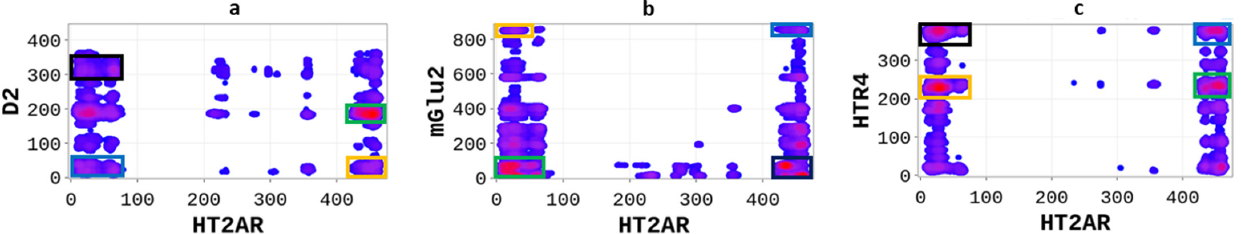
Figure 4. Differential heterodimerization of 5-HT2AR/D2R ( a ), 5-HT2AR/mGluR2 ( b ), and 5- HT2AR/5-HTR4R ( c ). The SP-DCA maps were obtained as described in the text using a total number of interacting aa, 𝑙 = 21 with optimized parameters 𝑎 = 𝑏 = 0.001. Amino acids are gradient color-coded: no interaction (white areas), medium interaction (blue), and highest probability of interaction (red spots). The rectangles delimit each heterodimer’s most likely interacting peptides (see text). The SP-DCA analysis of the 5-HT2AR/D2R heterodimer (Figure 4a) indicates that both receptors interact through (1) the C-terminal domain of 5-HT2AR and the N-terminal domain of D2R (AA: M1-Y37); (2) the N-terminal domain of 5-HT2AR (AA: M1-N75) and